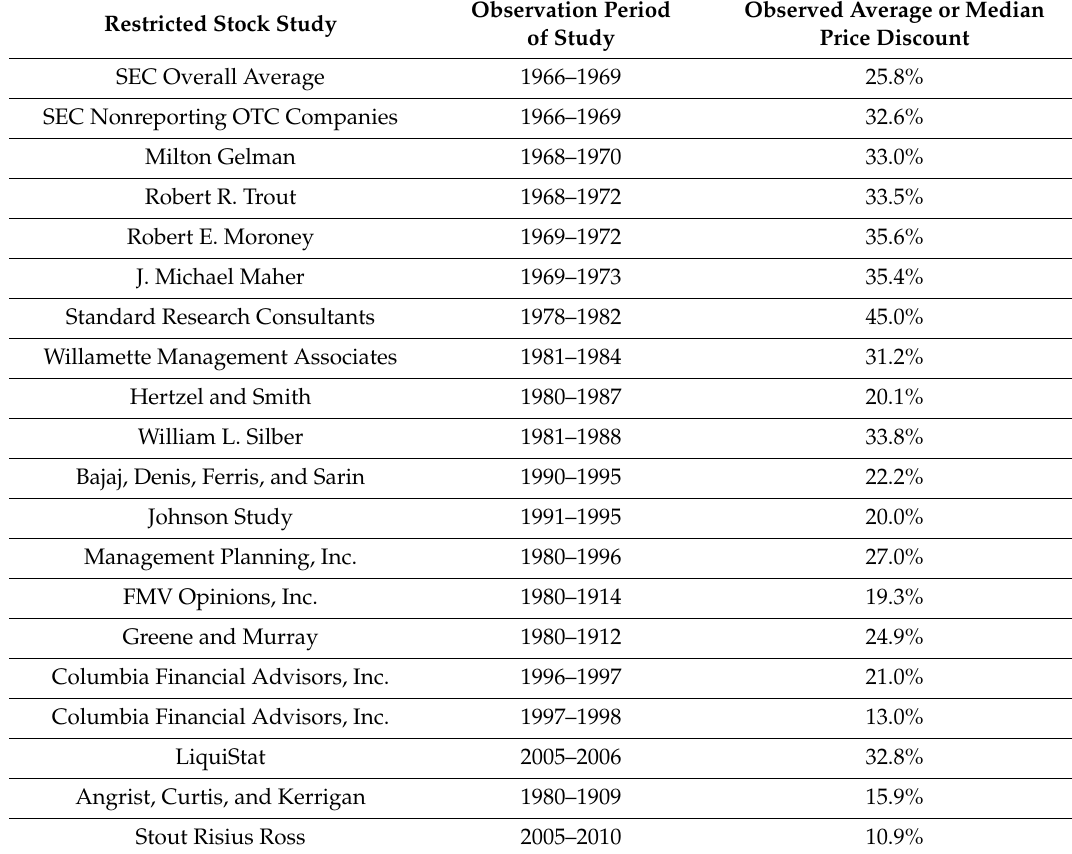
Table 1. Restricted stock studies, summary of implied level of discounts for lack of marketability